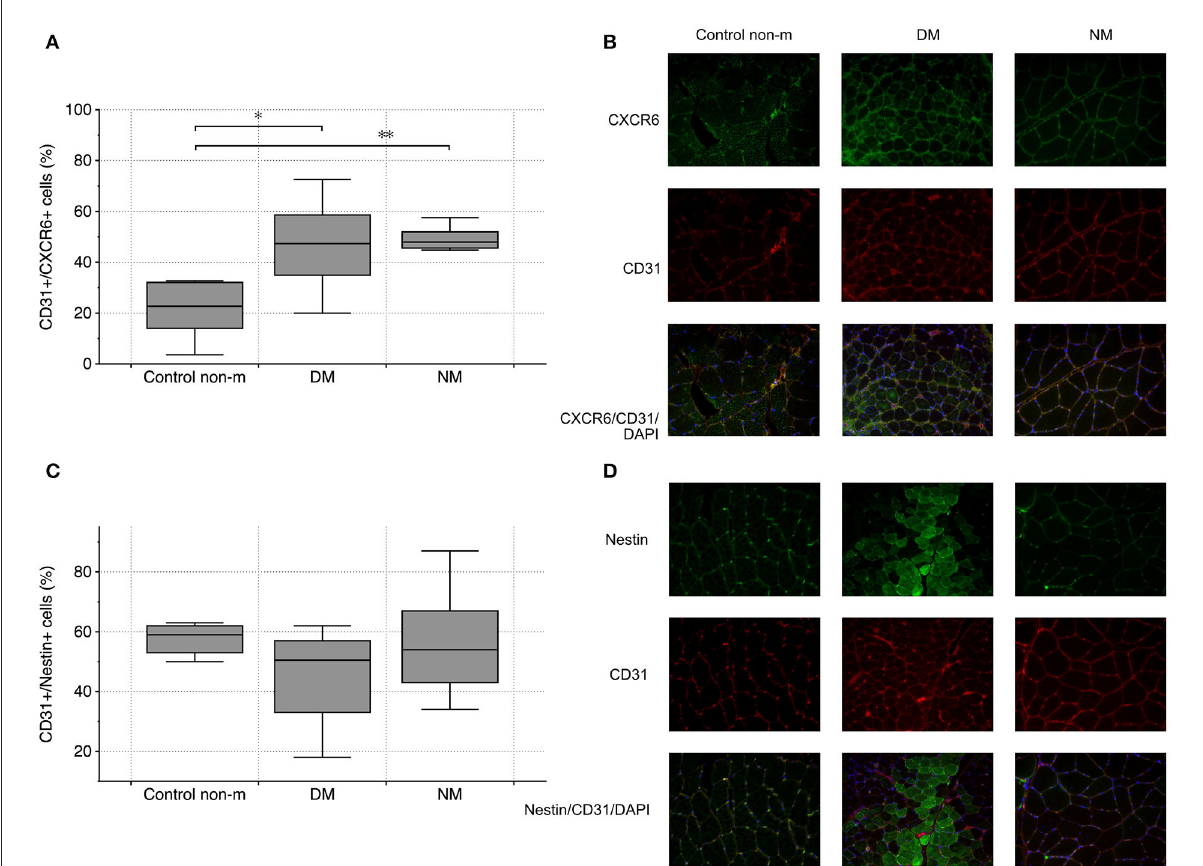
FIGURE3 Vascular CXCR6 expression and endothelial nestin abundance in controls (Control non-m) and in all disease groups. Endothelial (CD31 + ) cells showed more intense staining patterns for CXCR6 in DM and NM than in controls (A) . The image panel [right-sided— (B)] shows representative images from the respective groups after staining for CXCR6 (green), CD31 (red), and after merging including the nuclei (blue). Endothelial nestin did not differ between any of the groups (C) . The fluorescence images on the right depict staining patterns of nestin and CD31 and of both markers combined (nestin (green), CD31 (red), and after merging, nuclei (blue)) (D) . The following numbers of samples were analyzed per group: Control non-m: n = 6; DM: n = 10; NM: n = 6 (Control non-m: non-myopathic control; magnification × 40; * and ** , p-values < 0.05).